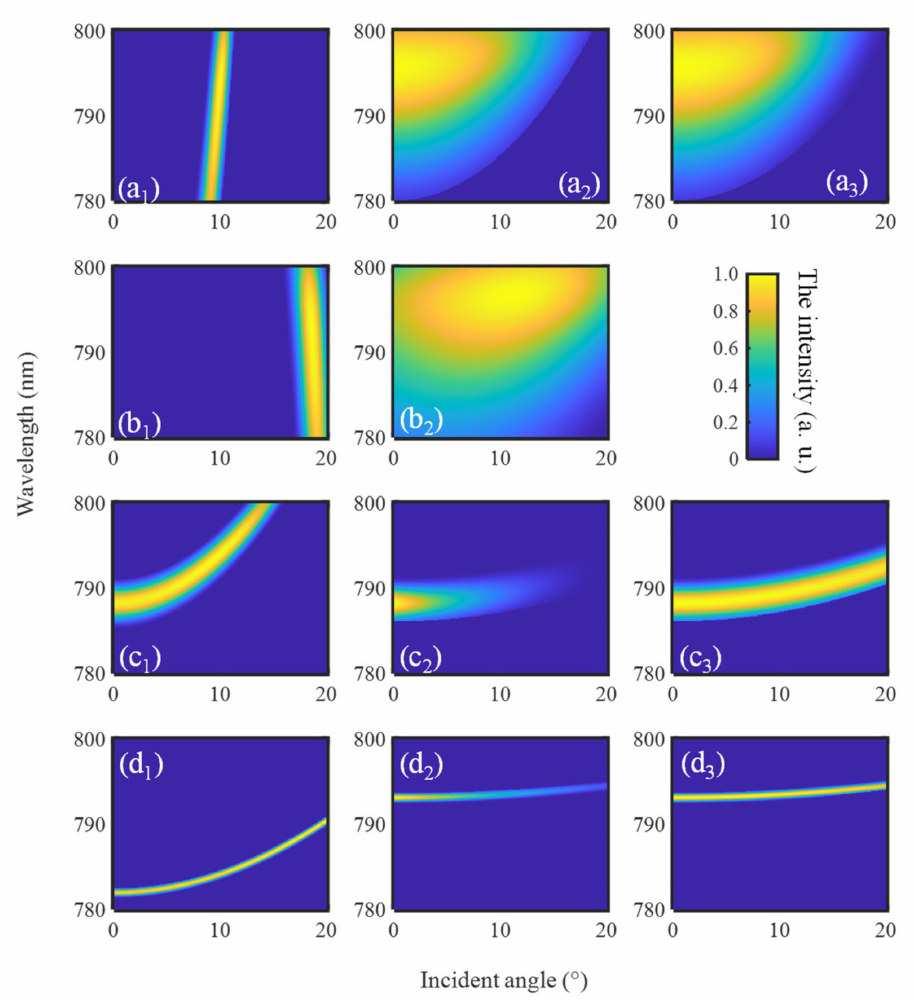
Figure 11. The calculation results of single peak shifts in the optical frequency domain. The figures ( a – d ) denote the nonlinear materials BBO, KDP, LiNbO 3 , and Ag 3 AsS 3 in order, the subscript numbers 1, 2, 3 denote the polarization combinations p-s, p-p, and s-s, respectively.